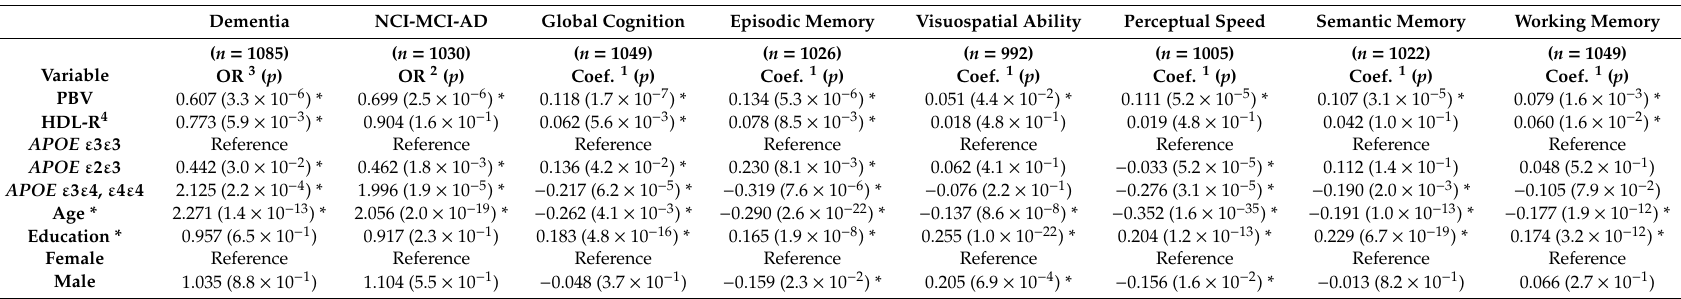
Multiple regression analysis was carried out to determine the associations of plasmalogen biosynthesis value (PBV), HDL ratio (HDL-R), APOE genotype, age, education and gender with odds of dementia (logistic regression), MCI / AD diagnosis (logistic regression) and cognitive scores (linear regression). 1 Coe ffi cients for continuous variables expressed per standard deviation (SD); multiple regression; 2 Odds ratios for continuous variables expressed per SD, ordinal logistic regression with AD / MCI / NCI as the outcome; 3 Odds ratios for continuous variables expressed per SD, multiple logistic regression; 4 HDL-R was mean normalized and log 10 transformed; 5 Age and Education were mean centered. For clarity, significant p values ( p < 0.05) are indicated by an asterisk